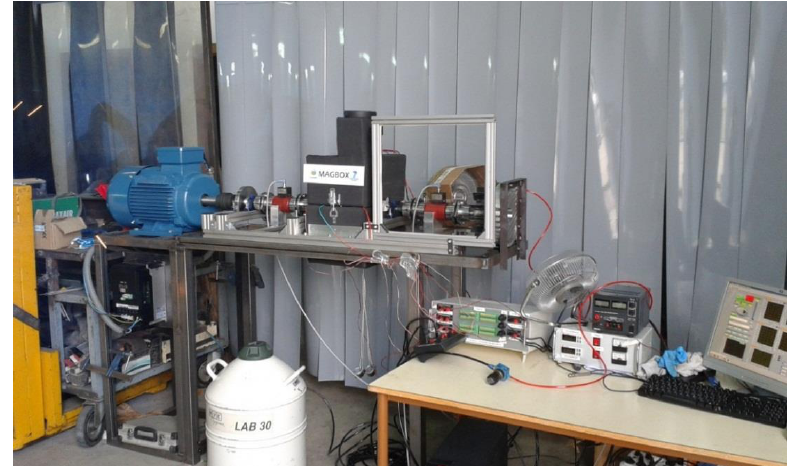
Figure 10. Aeronautical torque limiter ready for testing. The elements are (from left to right): AC motor, inertia disk, input torque-speed sensor, climatic chamber (torque limiter inside), output torque-speed sensor, brake cooling fan, pneumatic brake. On the table the data acquisition (DAQ) system is located.